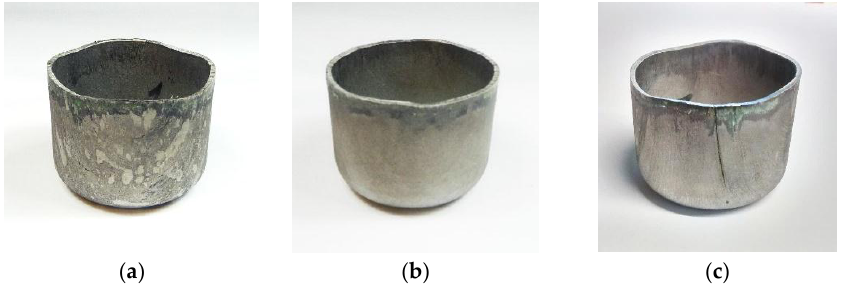
Figure 3. Deep-drawn cups at DR 2.0: ( a ) steel A; ( b ) steel B; and ( c ) steel C.